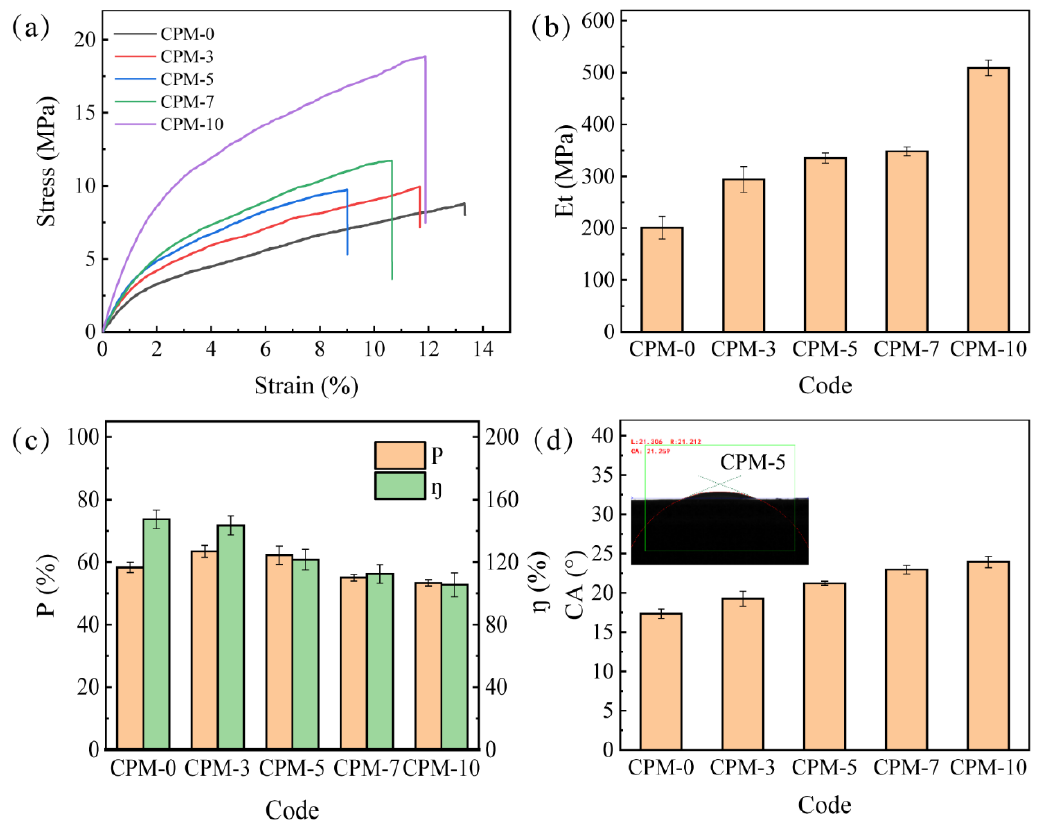
Figure 4. ( a ) The strain – stress curves of CPMs; ( b ) elastic modulus of CPMs; ( c ) porosity and liquid electrolyte uptake ratio of CPMs; ( d ) contact angle between liquid electrolyte and